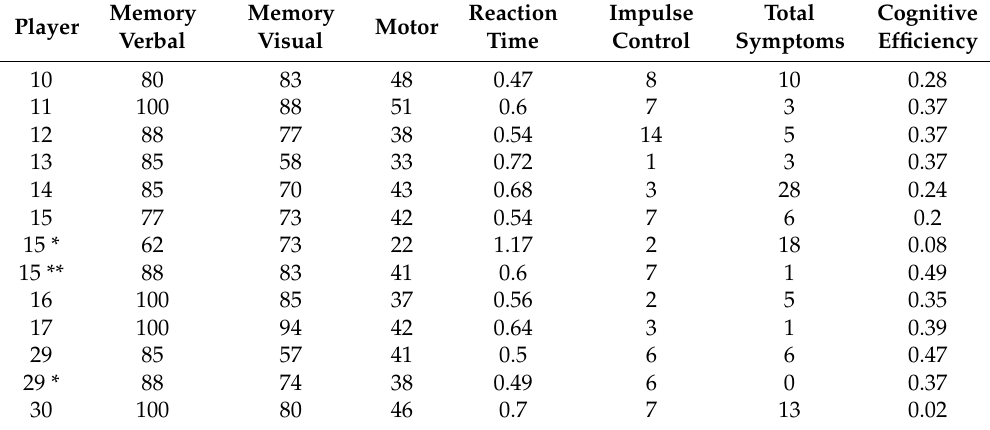
Table 1. IMPACT (Immediate Post-Concussion Assessment and Cognitive Testing) data on the soccer athletes studied. The rows with no asterisk are baseline measures prior to concussive events received during collegiate competition. The rows with one asterisk are data acquired within 48 h after concussion. The row with a single asterisk for Players 15 and 29 includes data obtained within 48 h after concussion. The row with two asterisks for Player 15 includes data acquired 5 days after